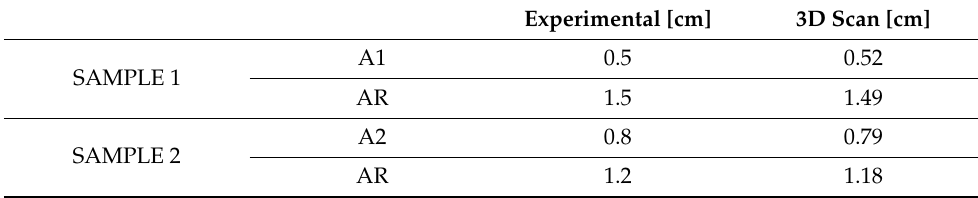
Table 4. Comparison between Lci values measured experimentally and through 3D scan (test